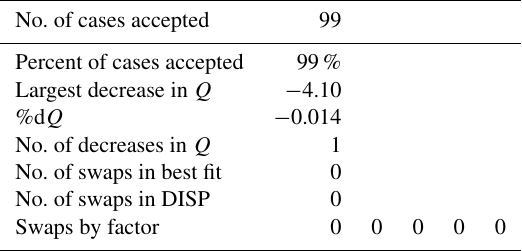
Table A3. BS-DISP